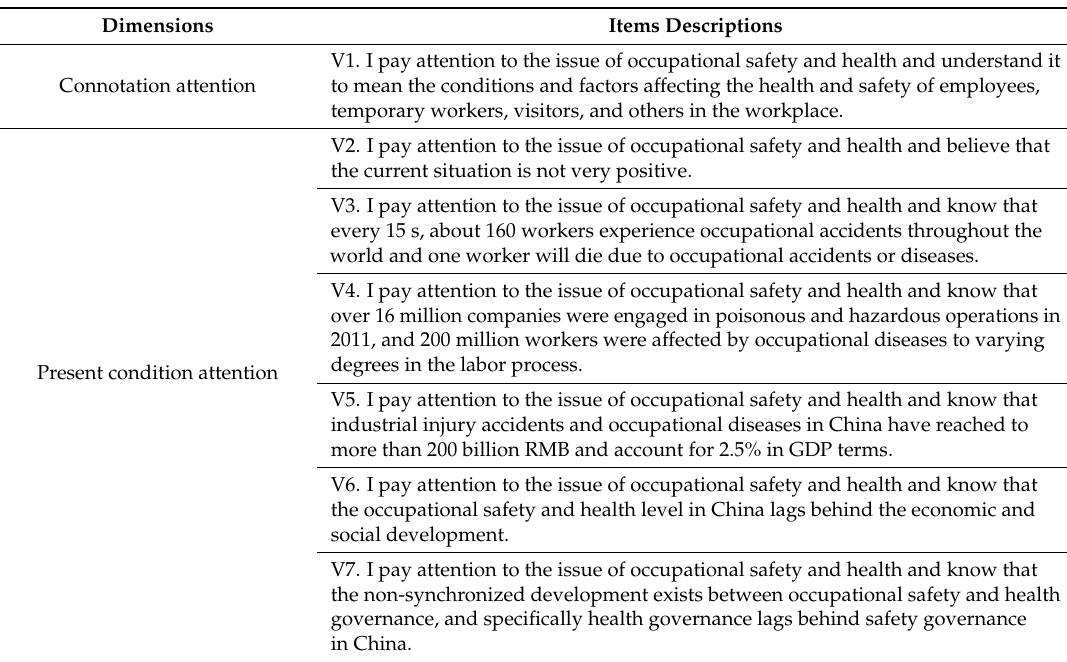
Table A1. The 13 items for attention and the four items for